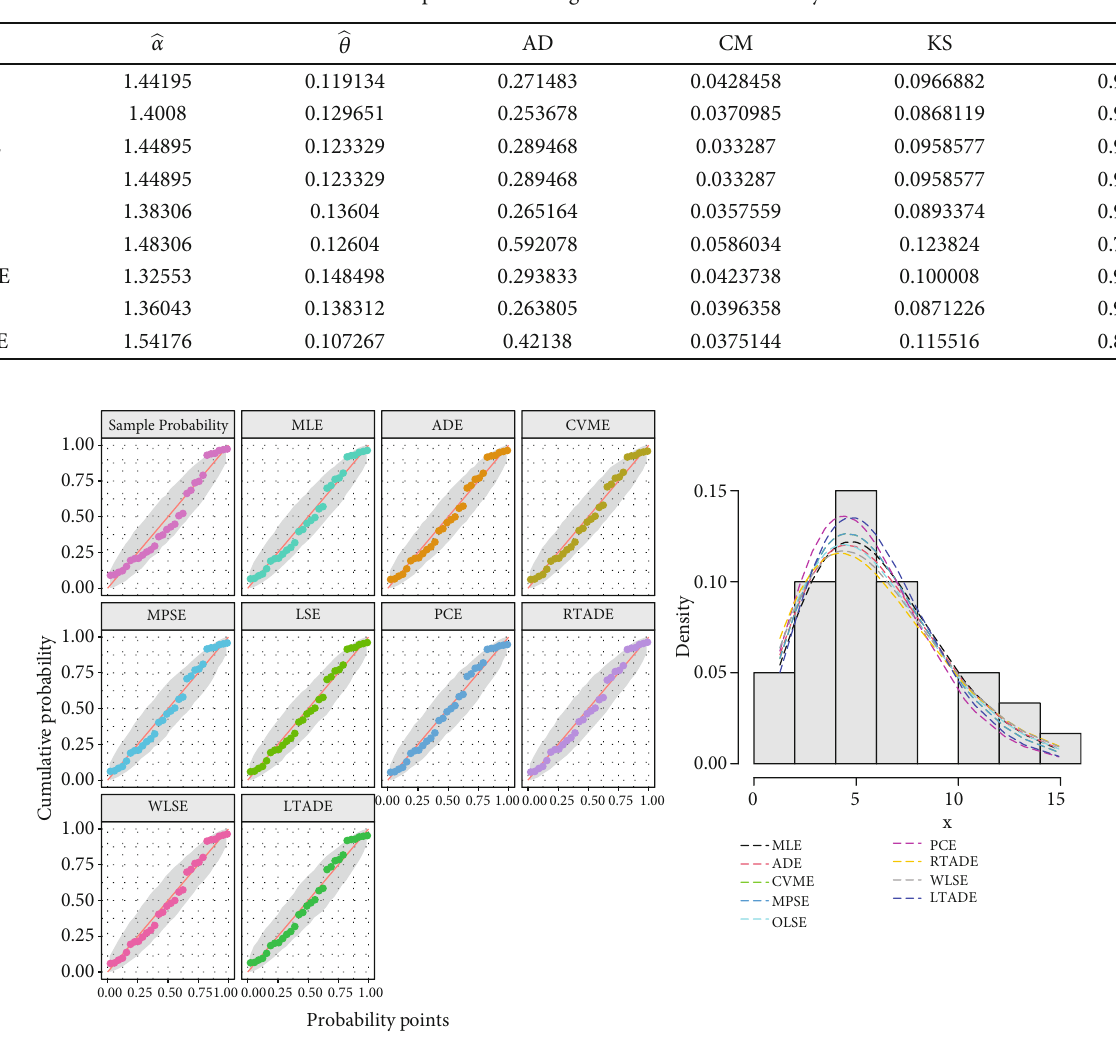
Figure 8: P-P plots and the estimated PDFs of the PXL